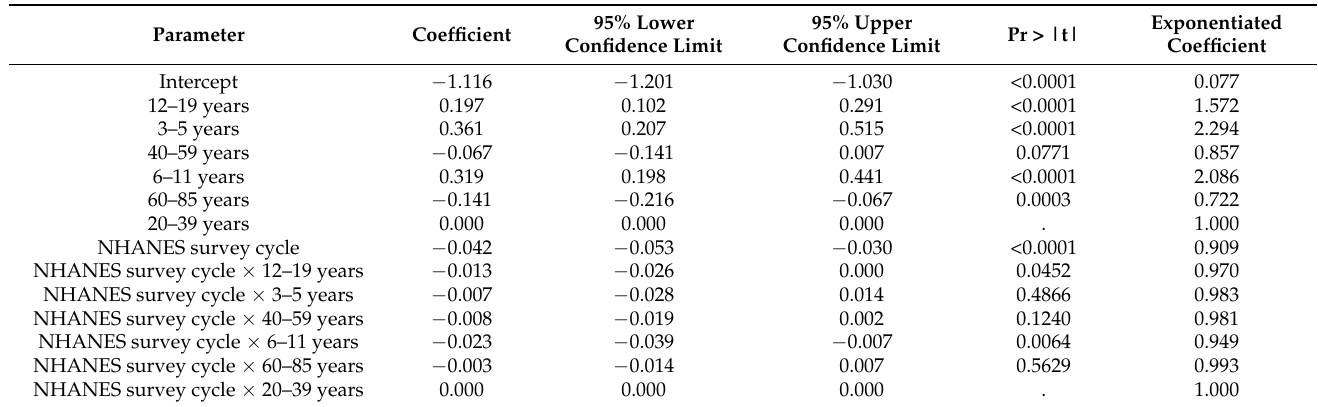
Table A6. Sample-weighted linear regression model results of serum cotinine for U.S. nonsmokers aged ≥ 3 years by age from 2003 to 2018.